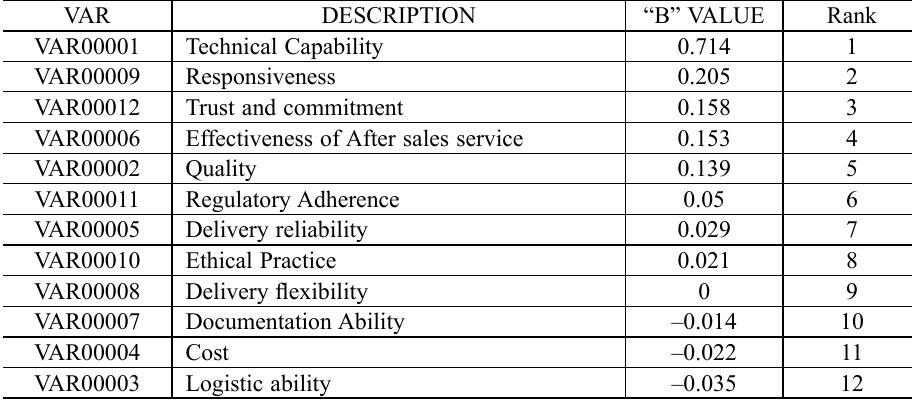
Table 5. Ranking of Supplier Performance